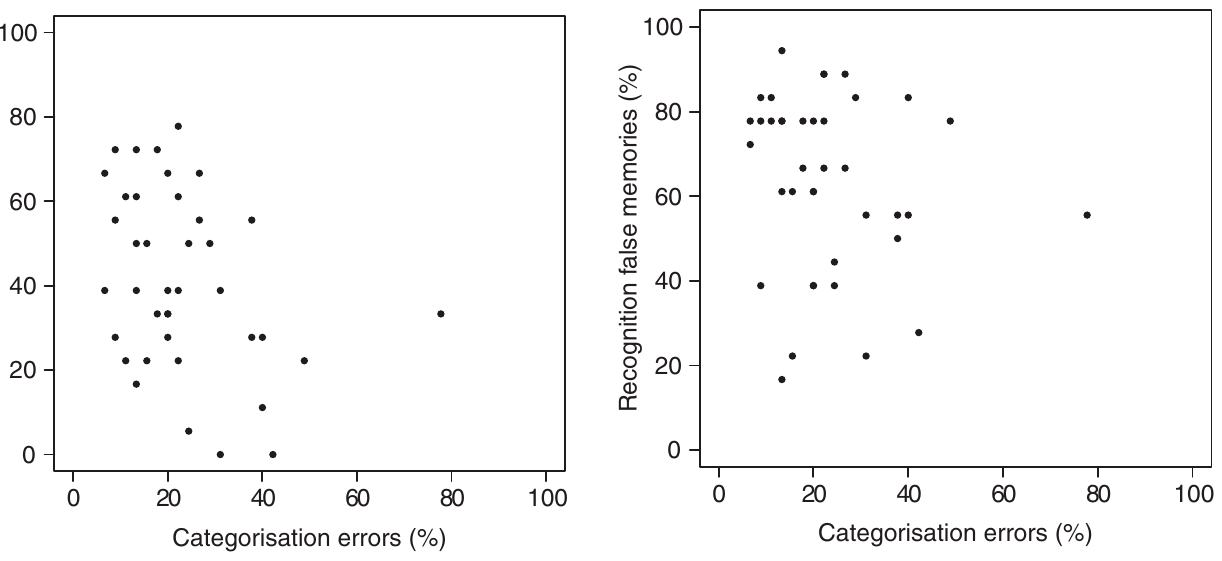
Figure 3. Categorisation ability versus false recognition. Figure 2. Categorisation ability versus false recall. Individuals’ Individuals’ categorisation abilities (given as the percentage categorisation abilities (given as the percentage of questions answered incorrectly on the categorisation test) plotted against their susceptibilities to false memories (given as the percentage of critical non-presented words recalled, out of those possible). Those individuals scoring fewer errors on the categorisation test were more susceptible to false memory intrusions and correspondingly had a higher false memory score (r =-0.345, df=37, p=0.032). s